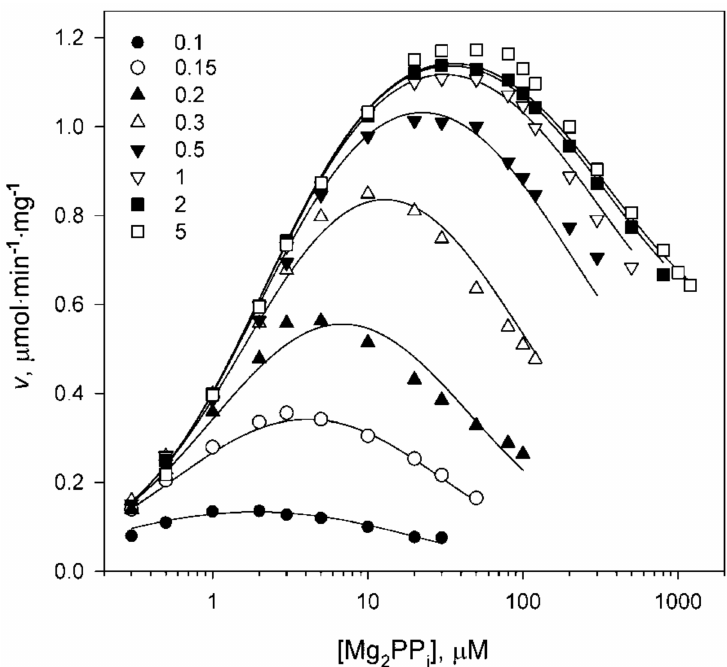
Figure 5. Kinetics of Dh-mPPase activation by Mg 2+ in the presence of 50 mM K + . The abscissa shows the substrate concentration. Mg 2+ concentrations (in mM) corresponding to different symbols are defined on the panel. The lines were calculated using Equation (3) with the parameter values found in Table 2.